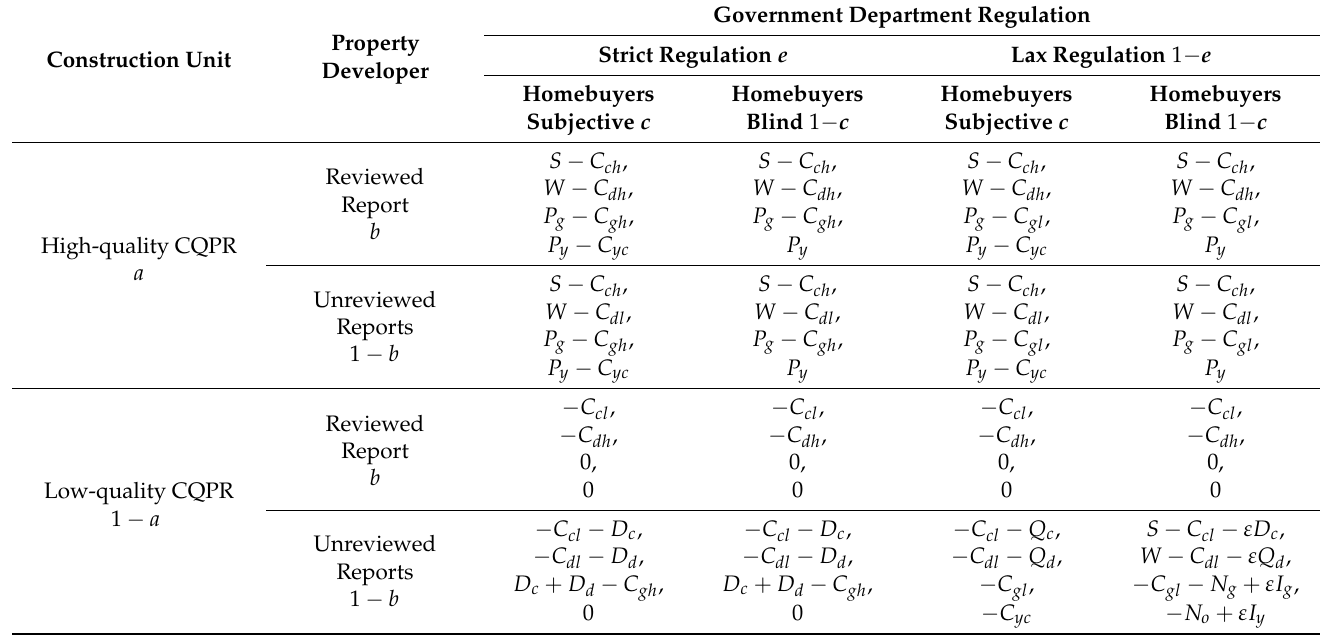
Table 1. Quadripartite game payoff matrix of construction stage quality supervision.